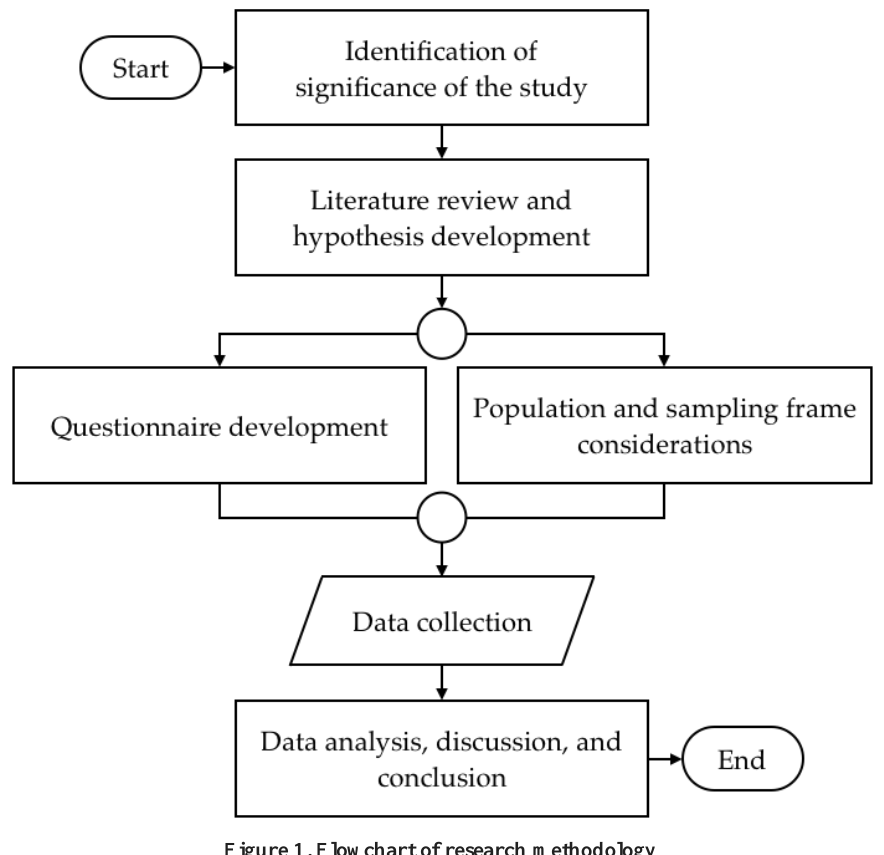
Figure 1. Flowchart of research